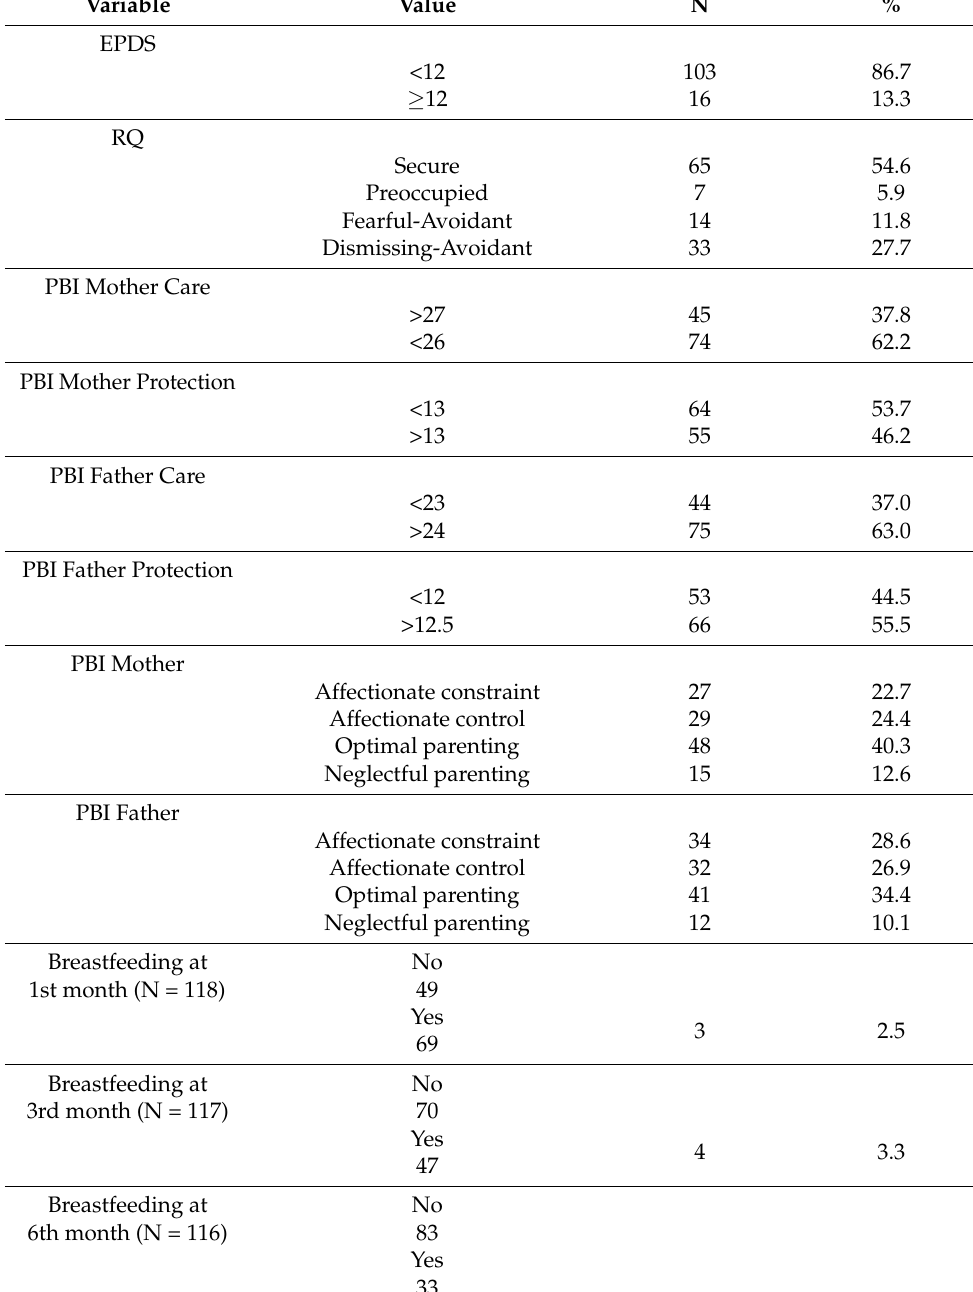
Table 2. The descriptive statistics of psychometric